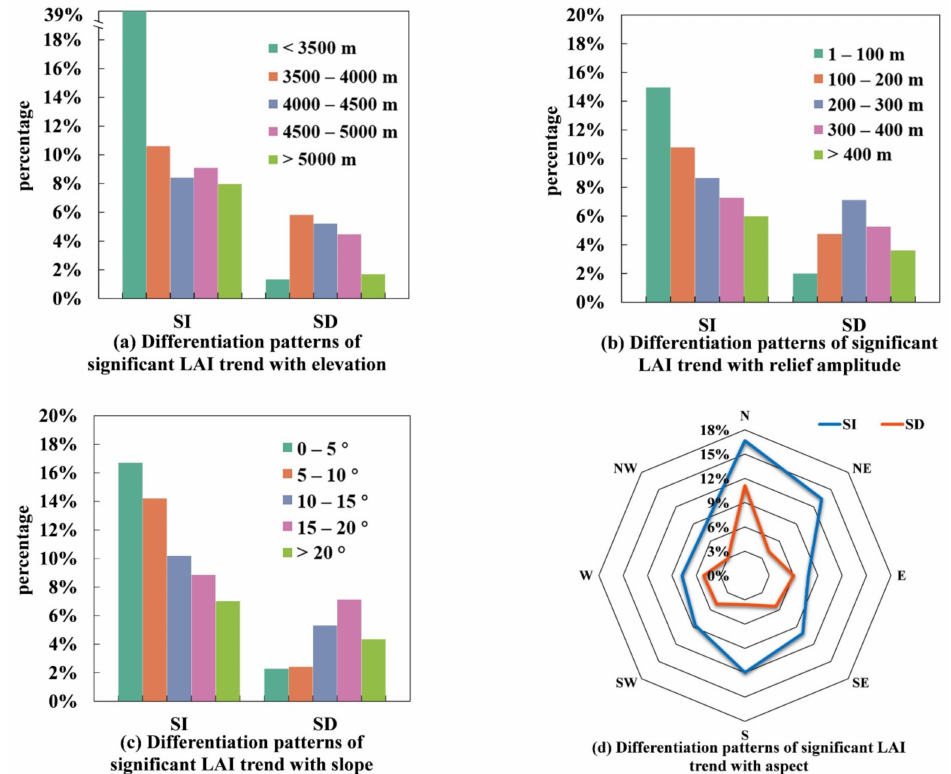
Figure 7. Differentiation patterns of significant LAI trends with ( a ) elevation, ( b ) relief amplitude, ( c ) slope, and ( d ) aspect. Meanings of the abbreviations are shown in Figure